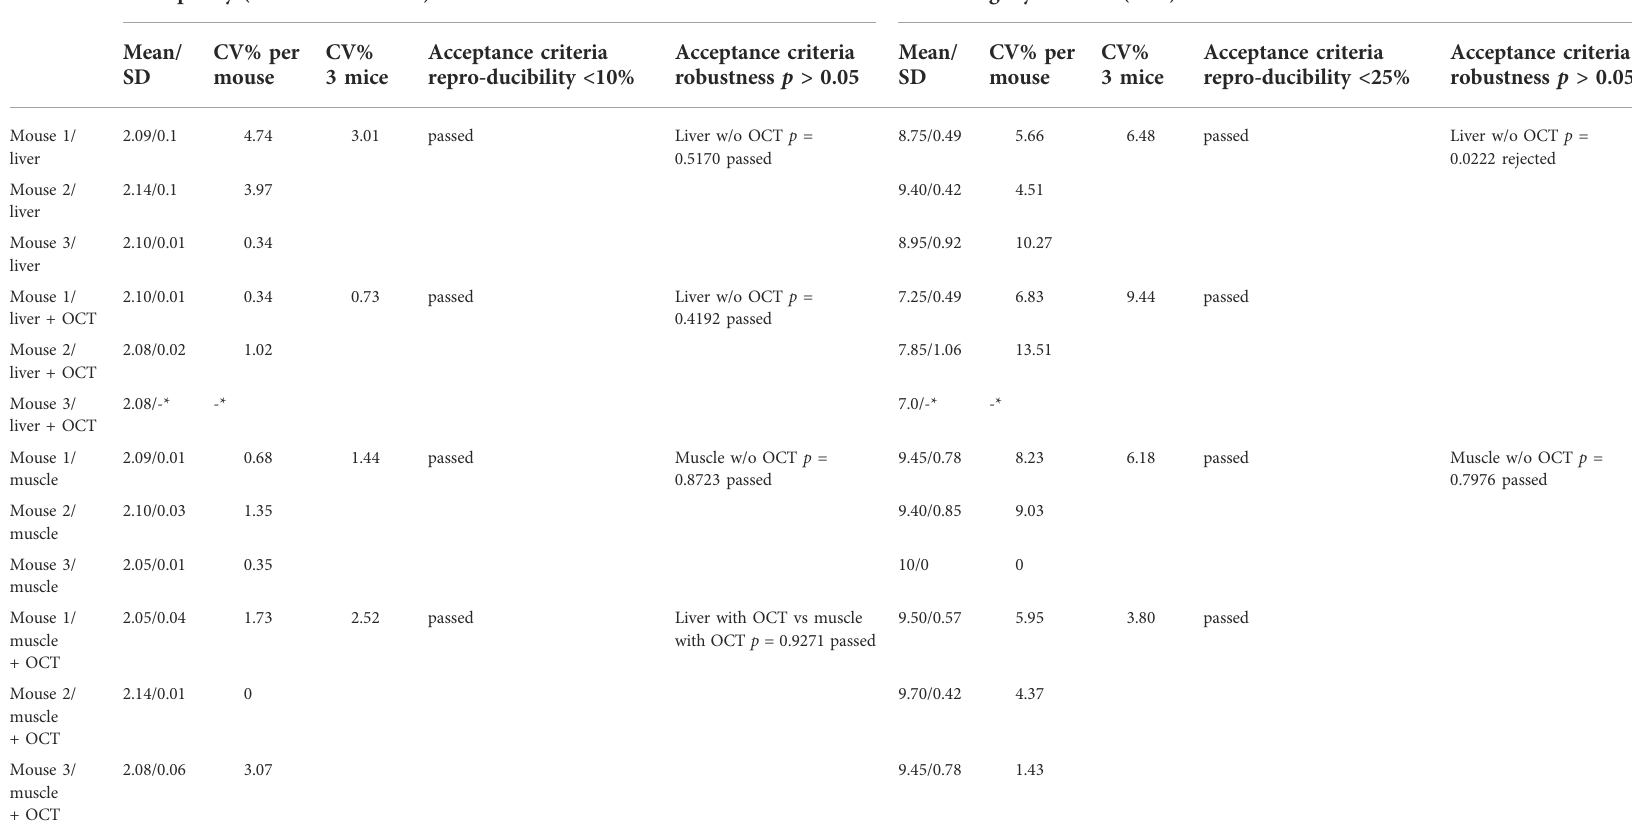
TABLE 4 Reproducibility and Robustness: Assessment of RNA purity and RNA integrity of liver and muscle samples direct frozen in liquid